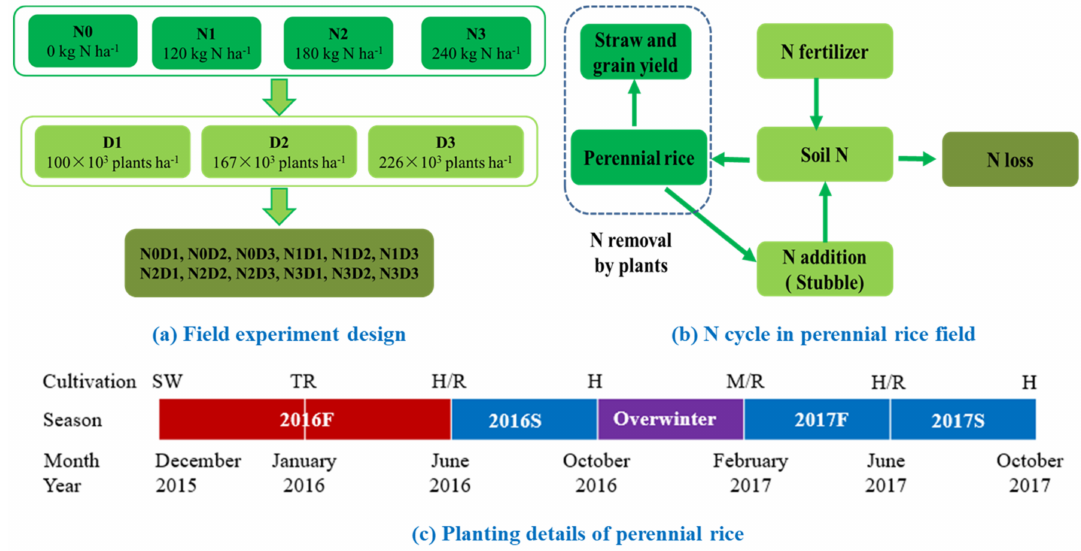
Figure 2. Field experiment design, planting details, and N cycle in the perennial rice field. ( a ) Field experiment design of different N rates and planting density. ( b ) N cycle in the perennial rice cropping system. ( c ) Planting details of perennial rice. SW, sowing. TR, transplanting. H, harvest. R, regrowth. M, stubble management (cutting back). 2016F, first season (red color) from sowing to the first harvest. 2016S, 2017F, and 2017S, three regrowth seasons (blue color) from regrowth to harvest each season. Overwinter, from the last harvest in the first year in winter to the first regrowth in the second